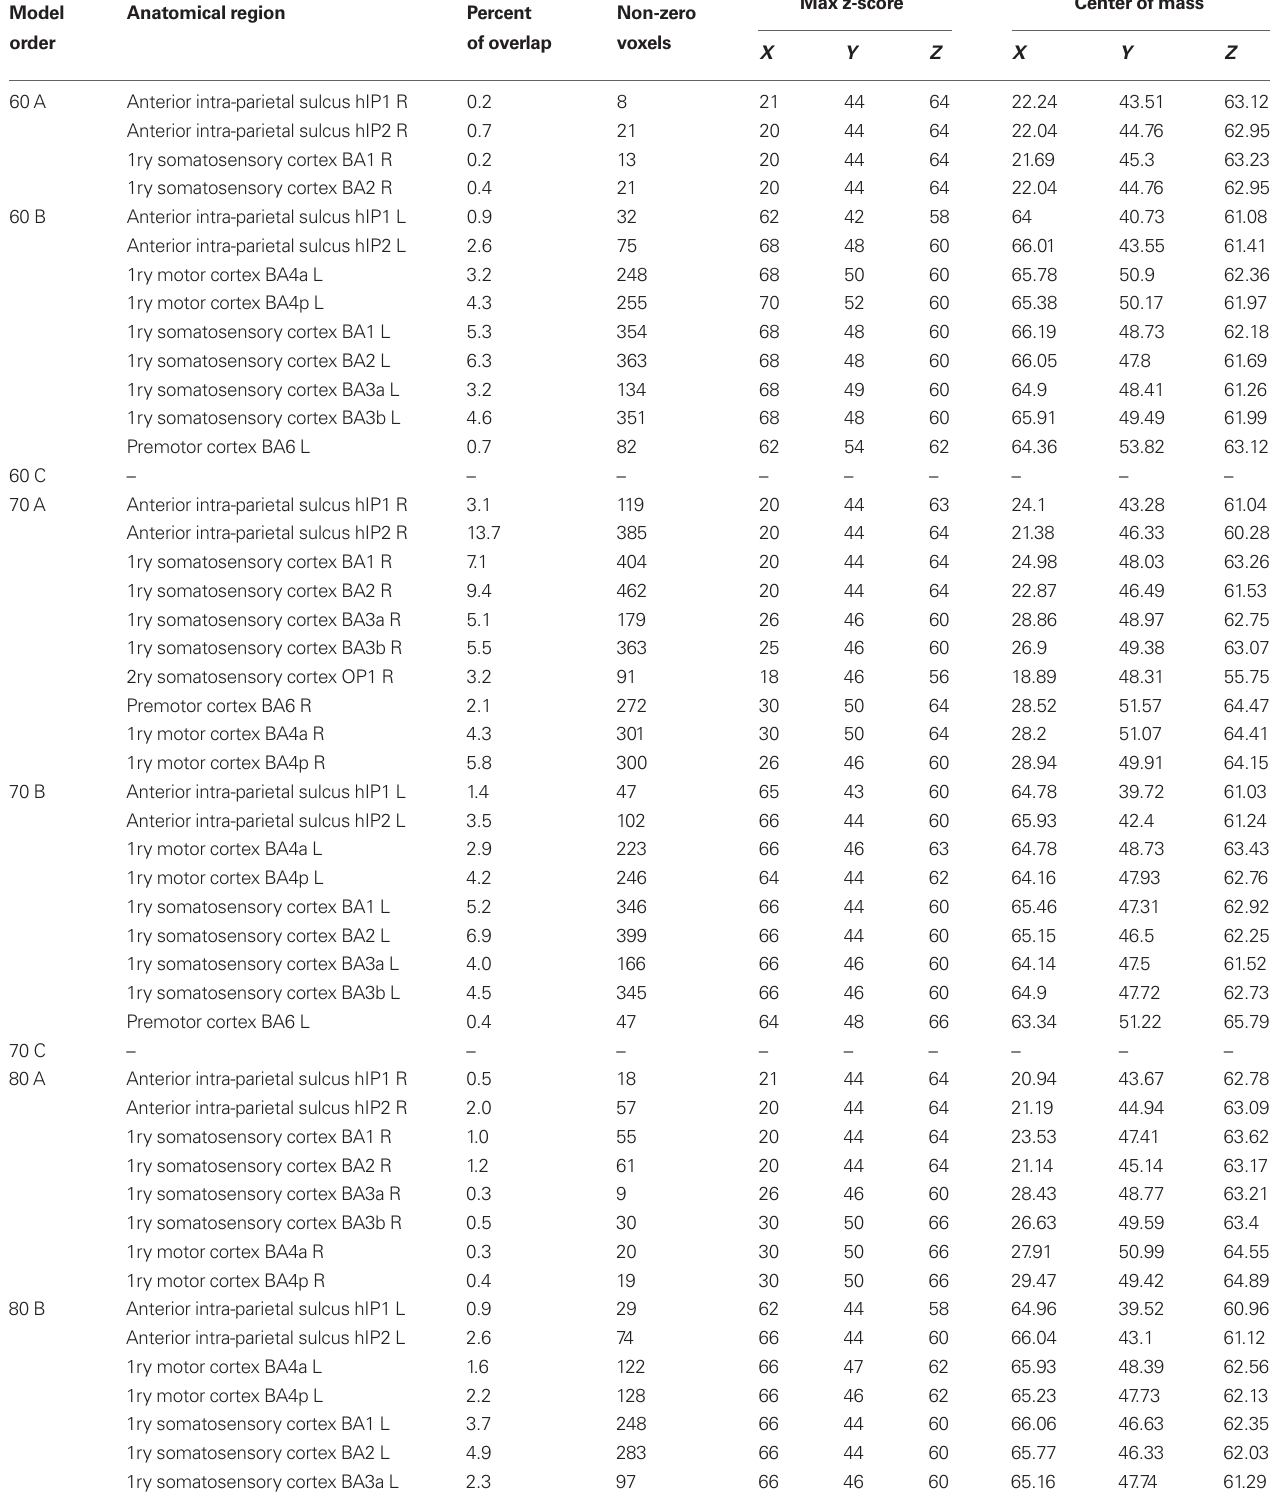
Table 6 | SAD functional connectivity differences in the motor cortex at all estimated ICA model